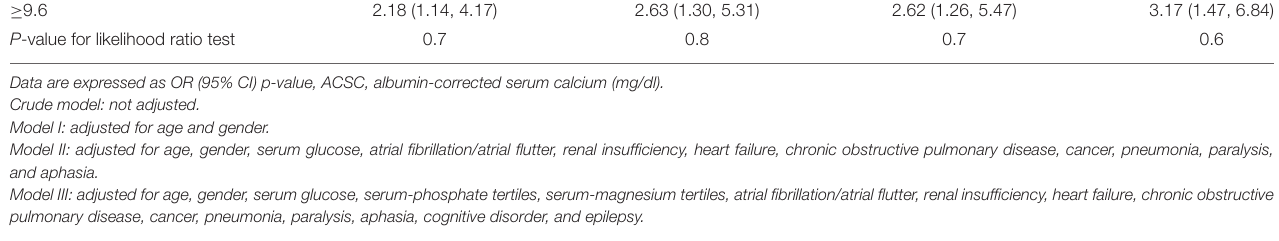
Model I: adjusted for age and gender. Model II: adjusted for age, gender, serum glucose, atrial fibrillation/atrial flutter, renal insufficiency, heart failure, chronic obstructive pulmonary disease, cancer, pneumonia, paralysis, and aphasia. Model III: adjusted for age, gender, serum glucose, serum-phosphate tertiles, serum-magnesium tertiles, atrial fibrillation/atrial flutter, renal insufficiency, heart failure, chronic obstructive pulmonary disease, cancer, pneumonia, paralysis, aphasia, cognitive disorder, and